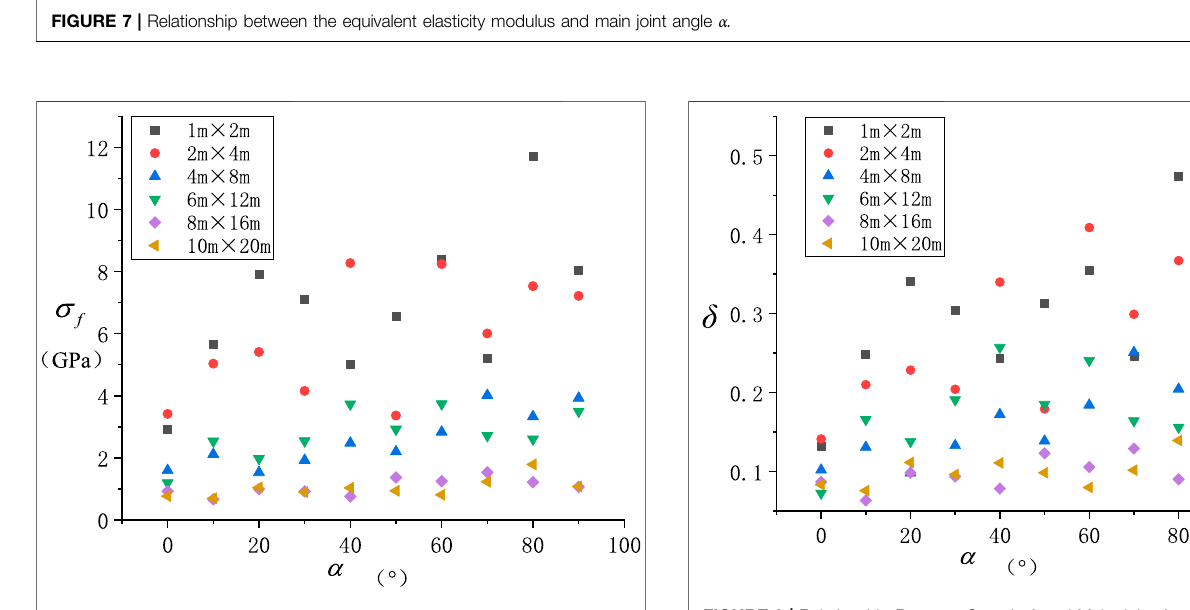
FIGURE 8 | Relationship between the standard deviation σ f of the equivalent elasticity modulus and main joint angle α ; relationship between sample δ and main joint angle α .